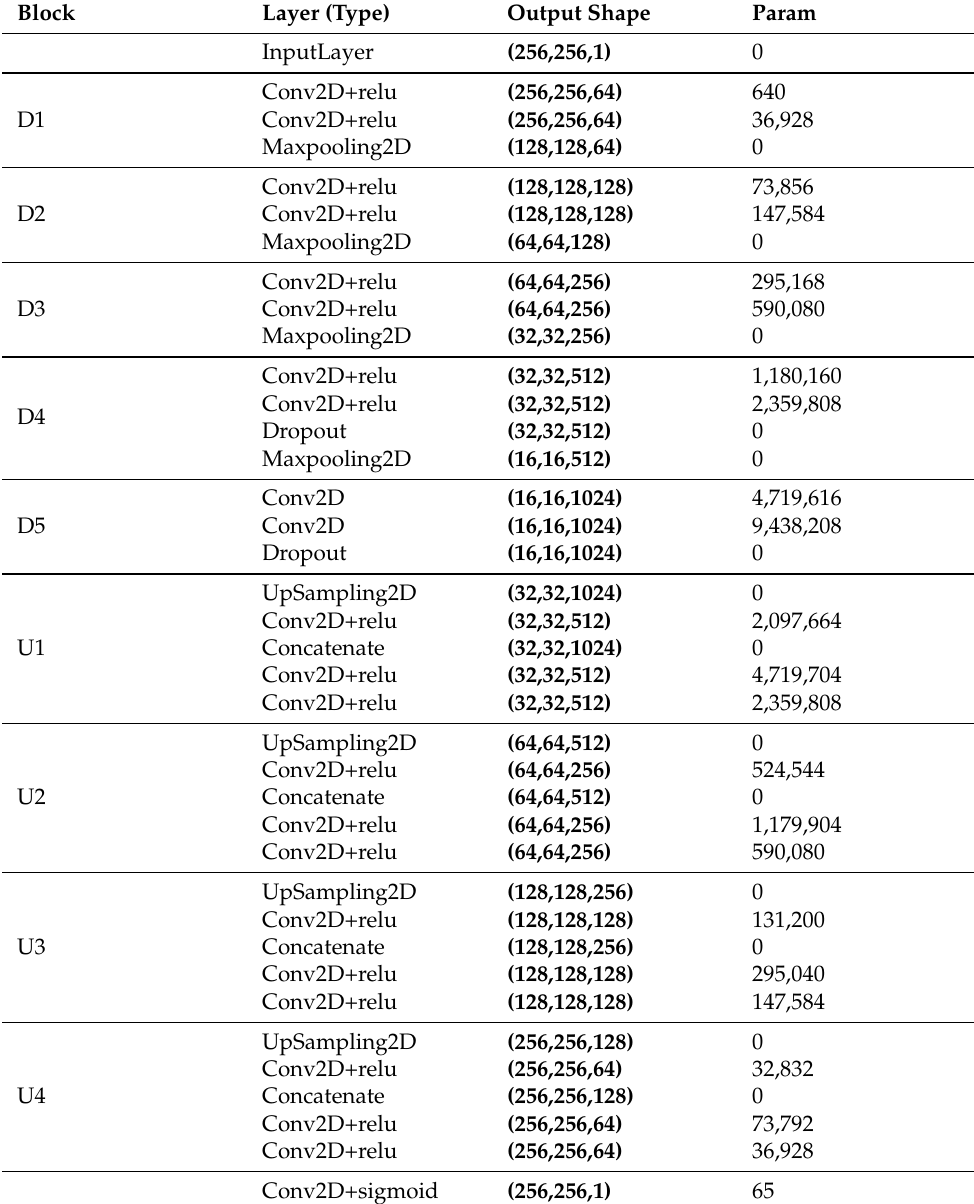
Table 1. The U-Net composition of the network. Block